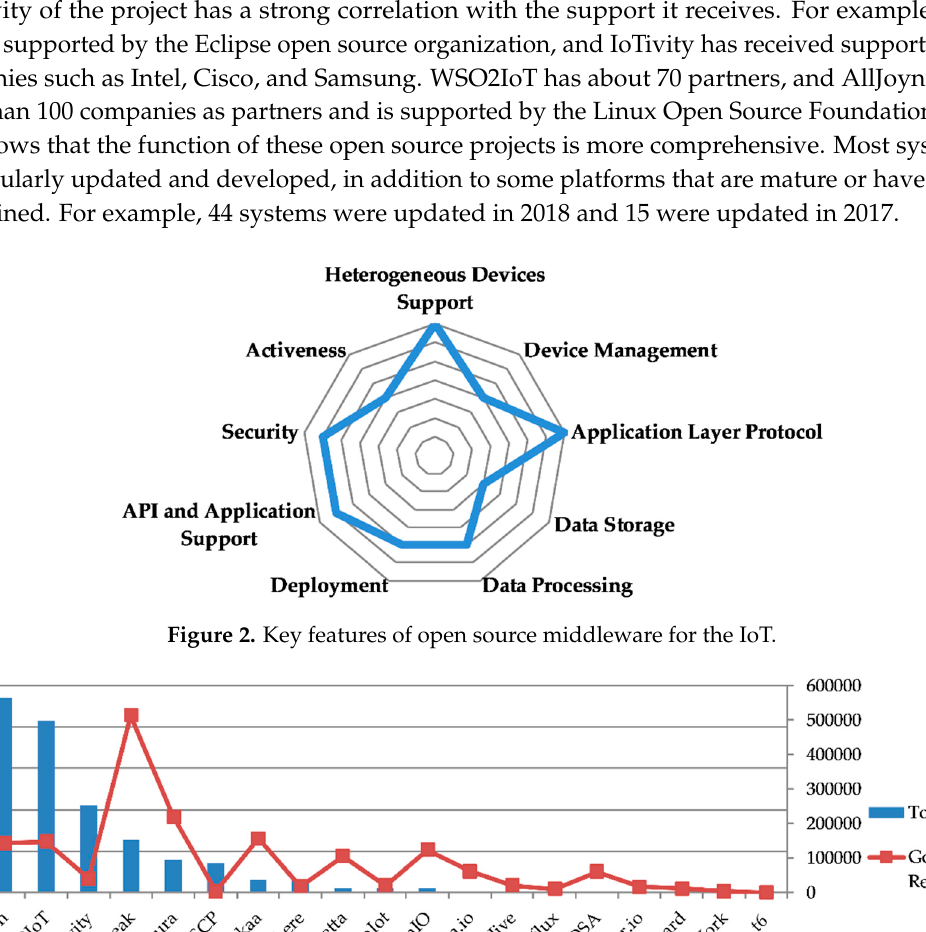
Table 3. Comparison of open source IoT middleware platforms.